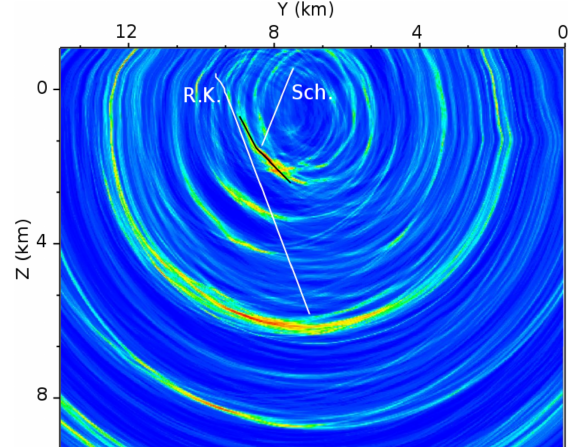
Figure 11. Comparison of the coherency image with the presumable Roter Kamm fault (R.K.) and Schwerin fault (Sch.) as derived from the geology map of the area. The deeper parts of these two structures are only extrapolated and not known.